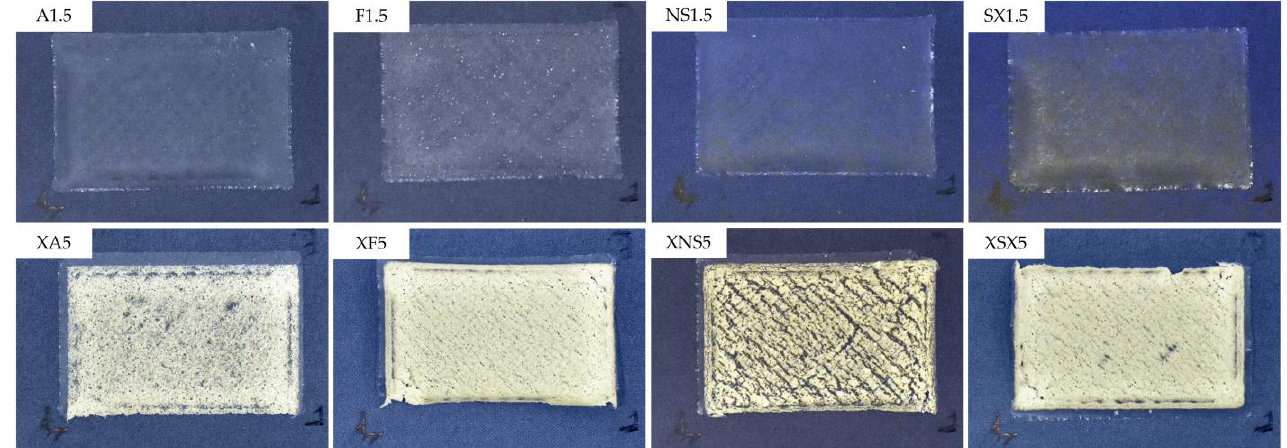
Figure 2. Appearance of selected samples of type A and type B ODFs.